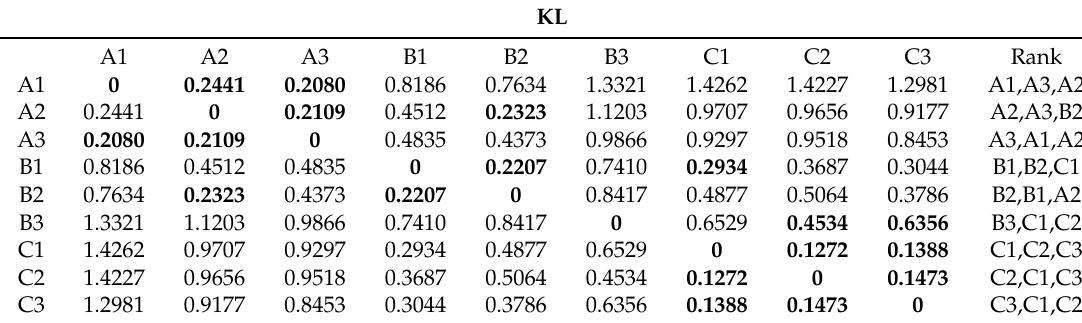
Table 4. The performance of KL for the AVIRIS dataset.